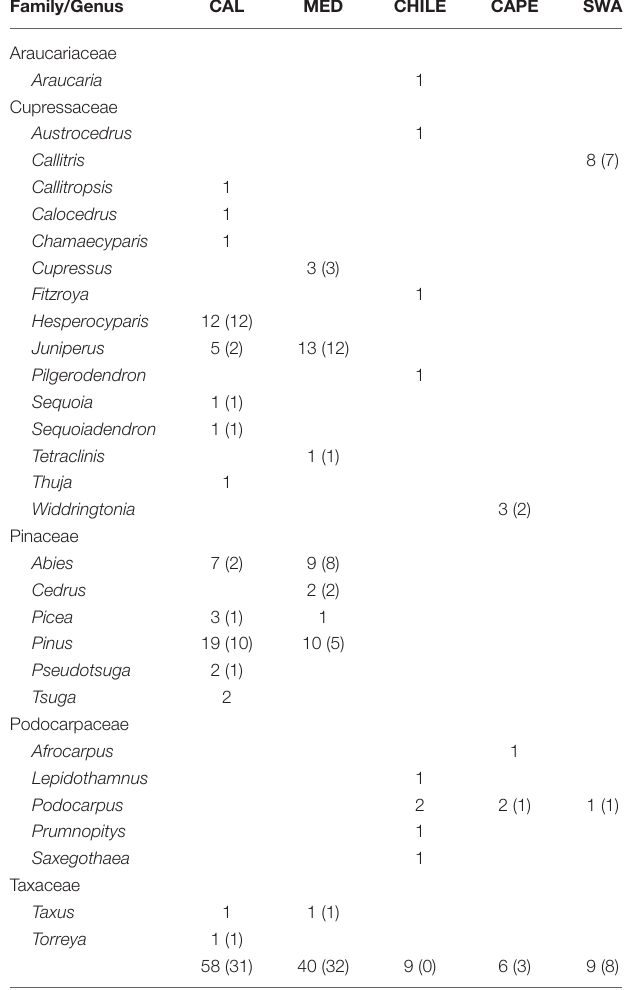
Numbers of endemic species shown in parentheses. The California MTC region is expanded to include the winter rainfall desert mountains and the Chilean MTC region is interpreted broadly to include winter rainfall Valdivian forests and adjacent areas of